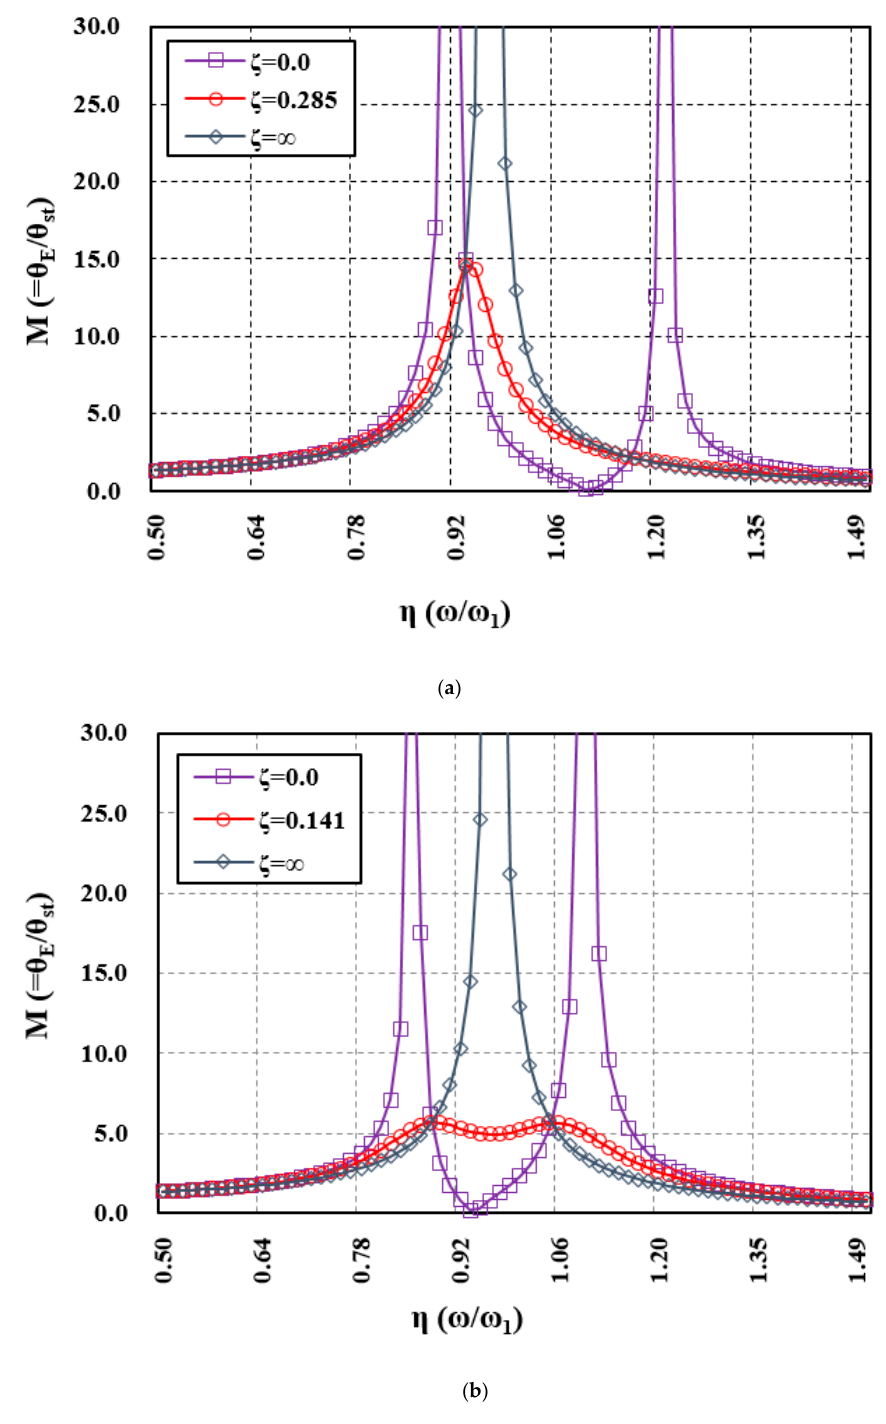
Figure 5. ( a ) Vibration characteristics of existing viscous-spring damper. ( b ) Vibration characteristics